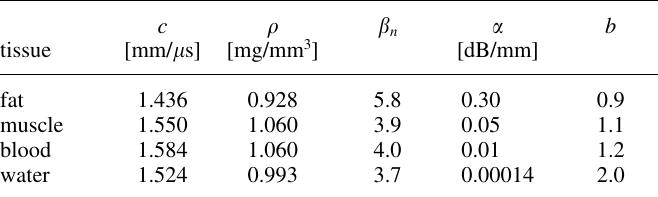
Table 1. Values for some physical parameters in medical ultrasound imaging at 1 MHz and 37 ° C. (See Duck (1990))